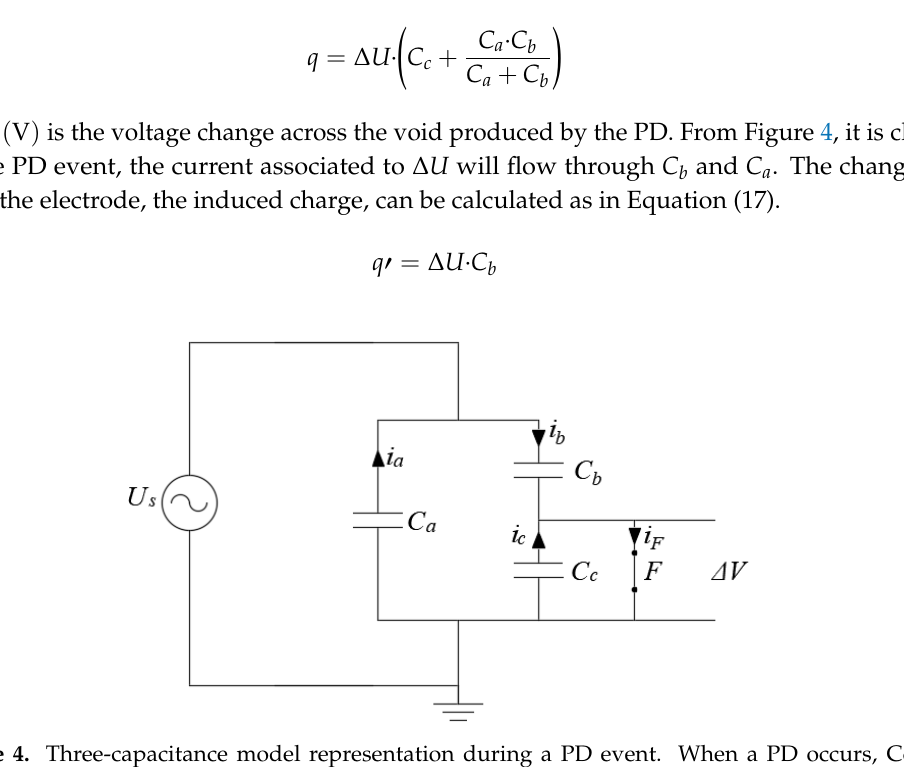
Figure 5. PD three capacitance equivalent circuit: ( a ) PD simulation using a switch in parallel to C c . The switch is controlled using voltage, phase and time as variables; ( b ) PD simulation using a variable resistance in parallel to C c . The value of the resistance is controlled using voltage, current and time as variables.